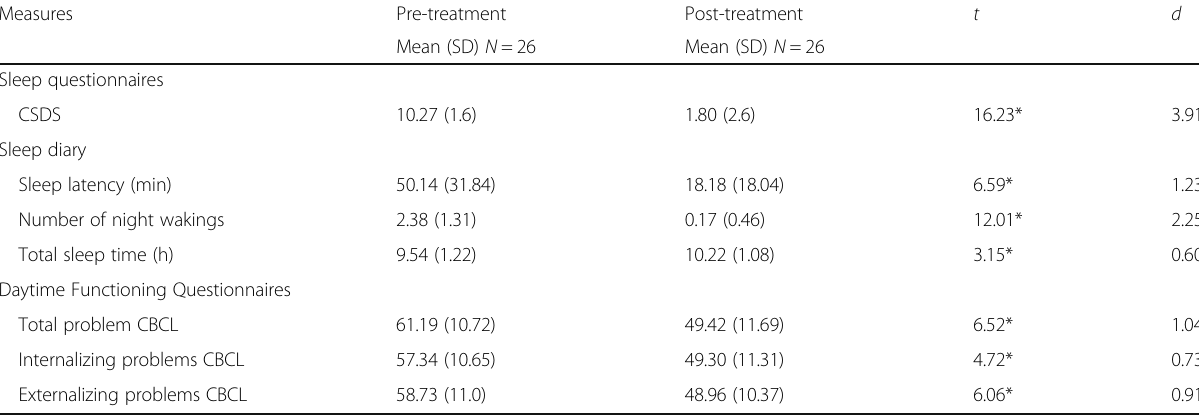
Table 4 Primary and secondary outcome measures in the second phase of the protocol Measures